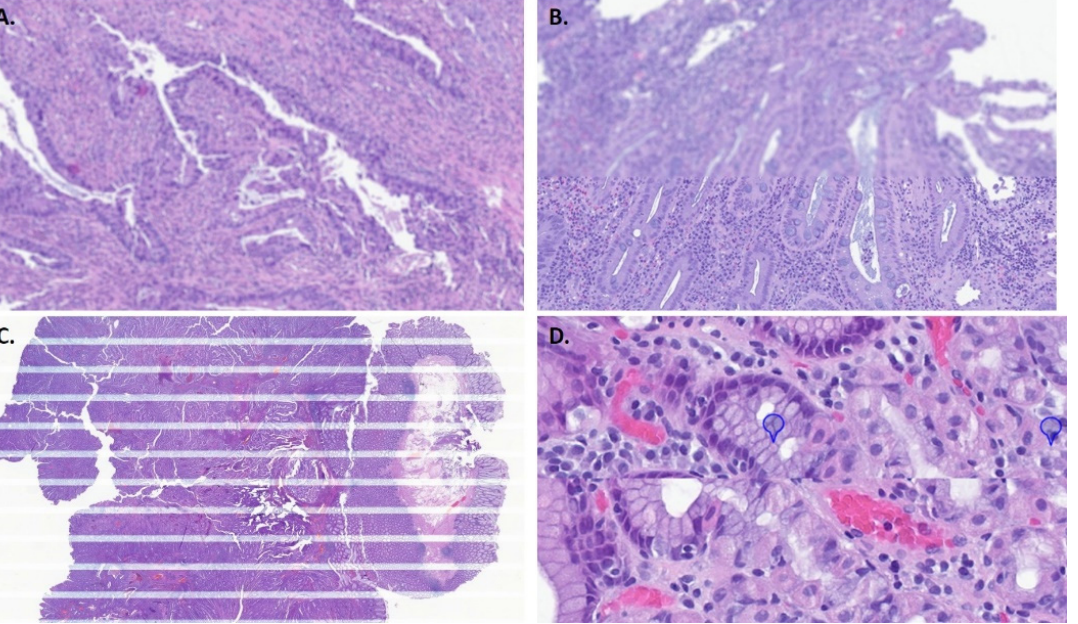
Figure 2. Errors detected in pathology quality control. ( A ). Out of focus. ( B ). Out of focus horizontal band. ( C ). Striping; ( D ). Stitch error/mismatch.